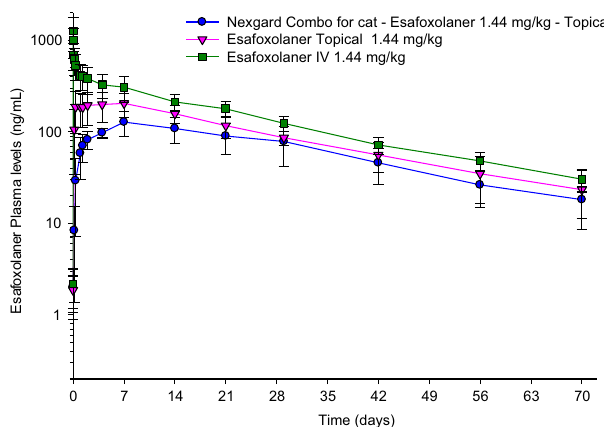
Figure 1. Esafoxolaner average concentration – time curves, when administered in NexGard (cid:1) Combo, or alone in a topical or in an intravenous